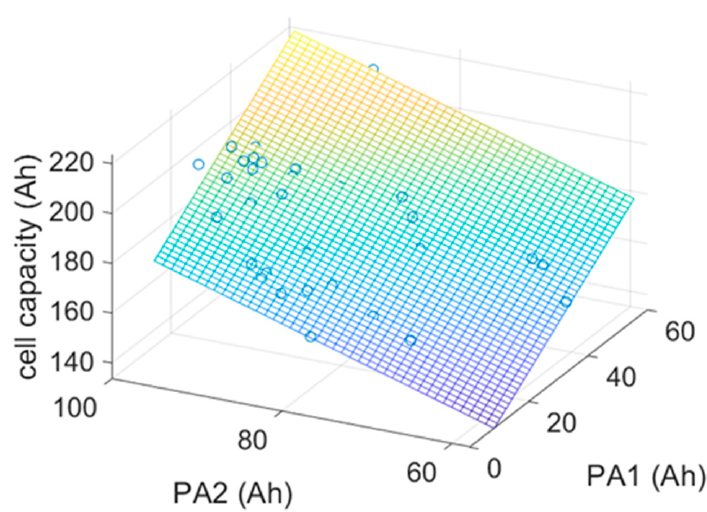
shown in Figure 6.